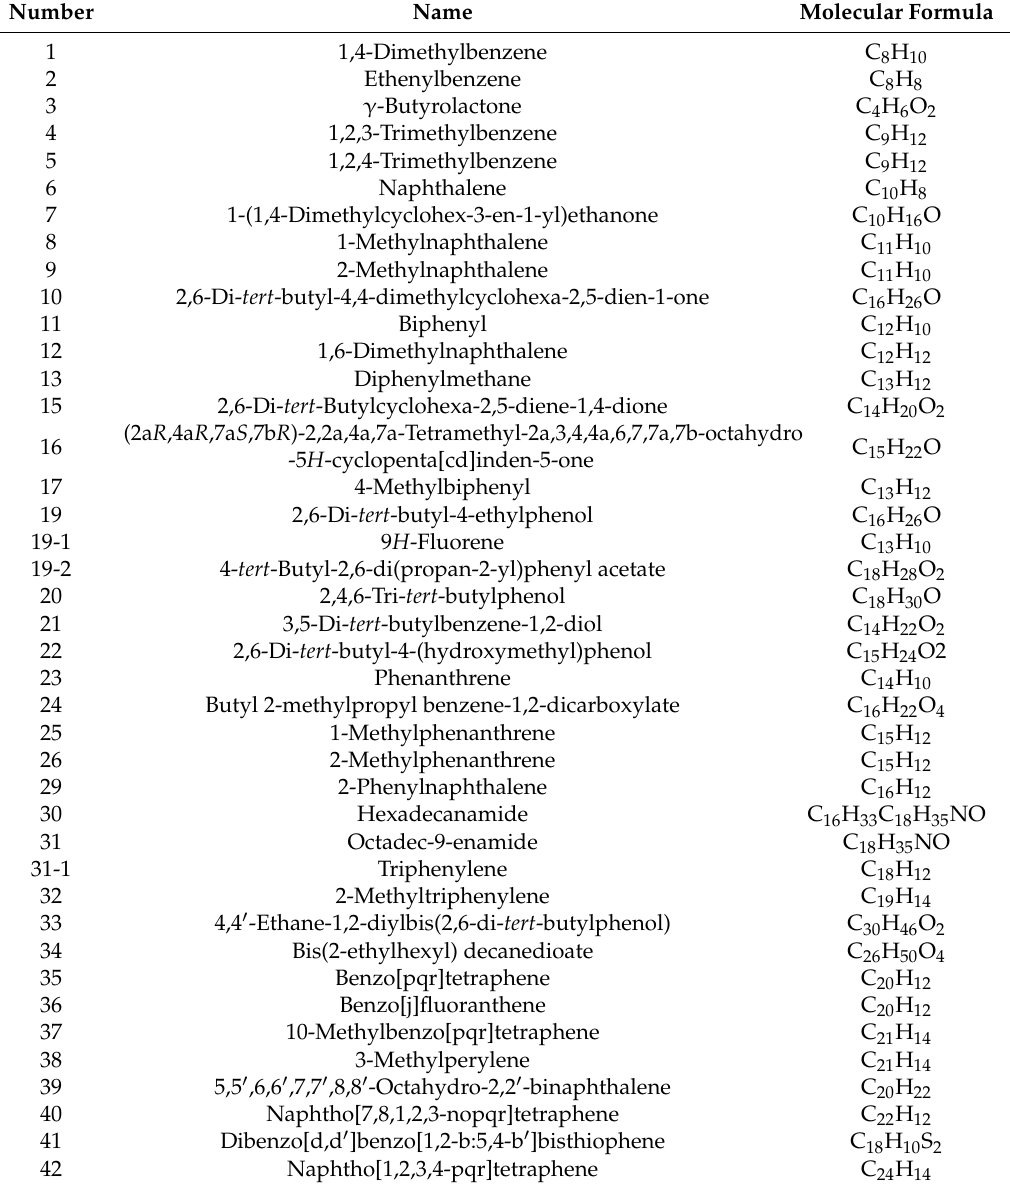
Table 2. YZS tetrahydrofuran extraction GC/MS analysis